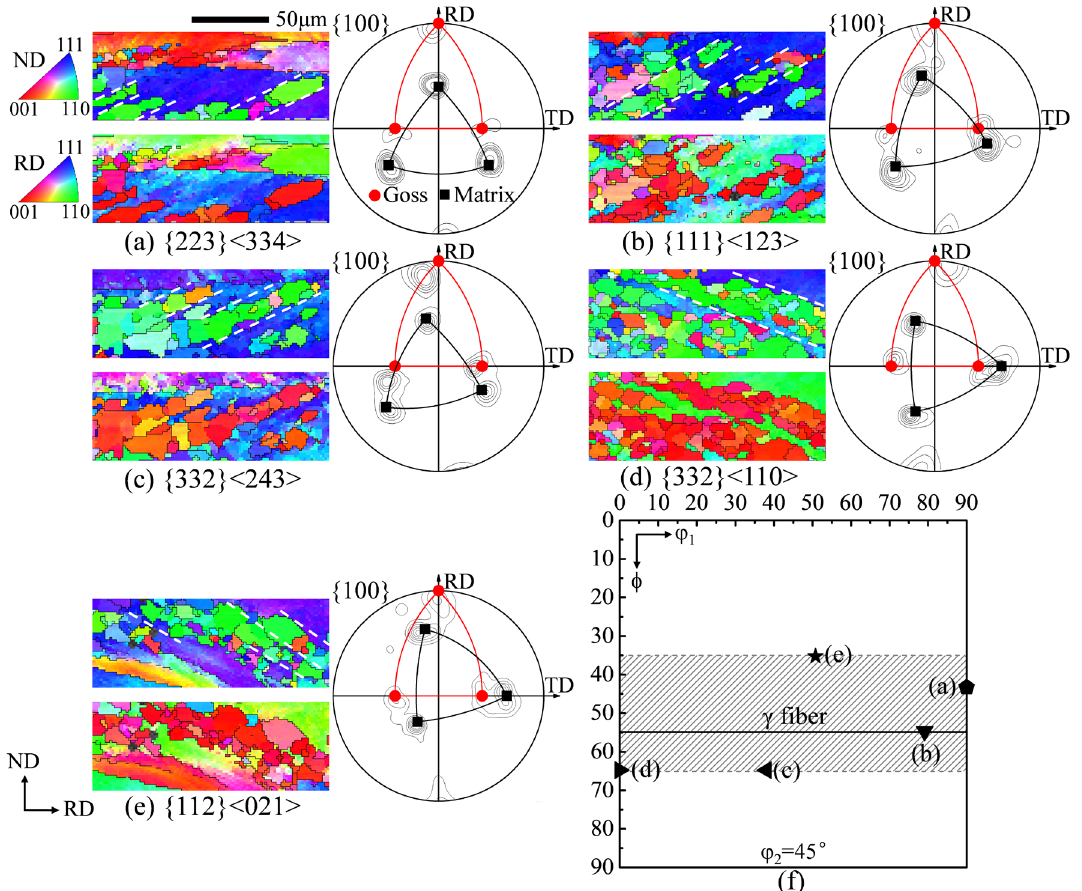
Figure 4. Orientation image maps and corresponding {100} pole figures of recrystallized grains and correspondingly surrounded deformed matrices in 10% recrystallized Fe-2.1 wt.% Si sheets: (a) {223}<334> matrix; (b) {111}<123> matrix; (c) {332}<243> matrix; (d) {332}<110> matrix; (e) {112}<021> matrix; (f) the crystal orientations of (a)-(e) matrices marked in the φ